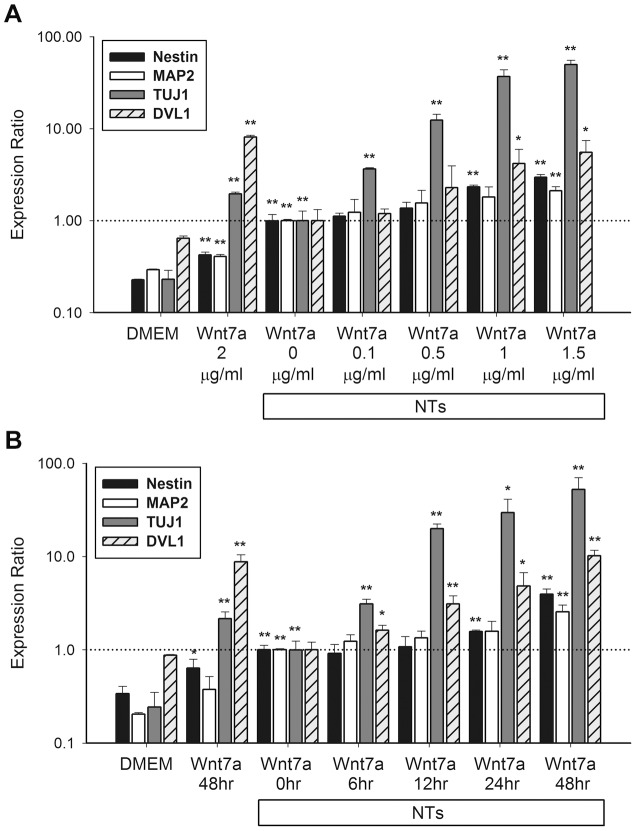
Dose- and time-dependent effects of Wnt7a in neurogenic hMSCs.mRNA levels of nestin, MAP2, neurotubulin, and DVL1 were quantified after 48 h of Wnt7a treatment (0.1∼1.5 µg/ml) in a dose-dependent study (A) and at various times (i.e., 6∼48 h) after Wnt7a treatment (2 µg/ml) in a time-dependent study (B). NTs combined with Wnt7a promoted expression of neuronal genes related to the canonical Wnt pathway in time- and dose-dependent manners. Levels were normalized to those of NTs treatments (set to 1.0). Data are presented as the mean ± SD of one triplicate experiment that was representative of three independent experiments. * p<0.05, ** p<0.01 (NTs and Wnt7a vs. DMEM; NTs+Wnt7a vs. NTs).